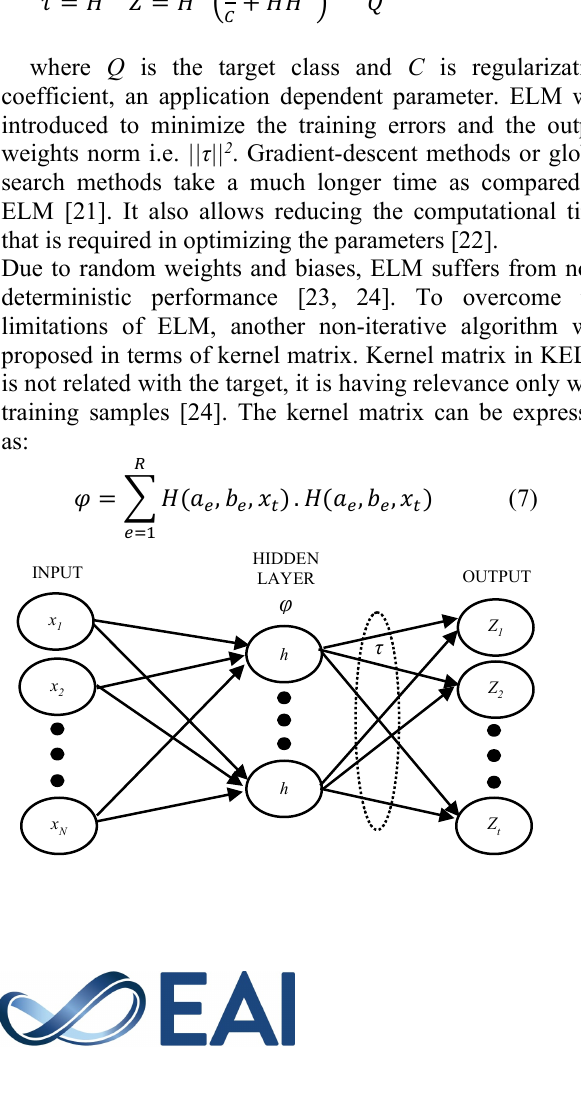
R N denotes the training data and t represents the where, x t number of training data ∈